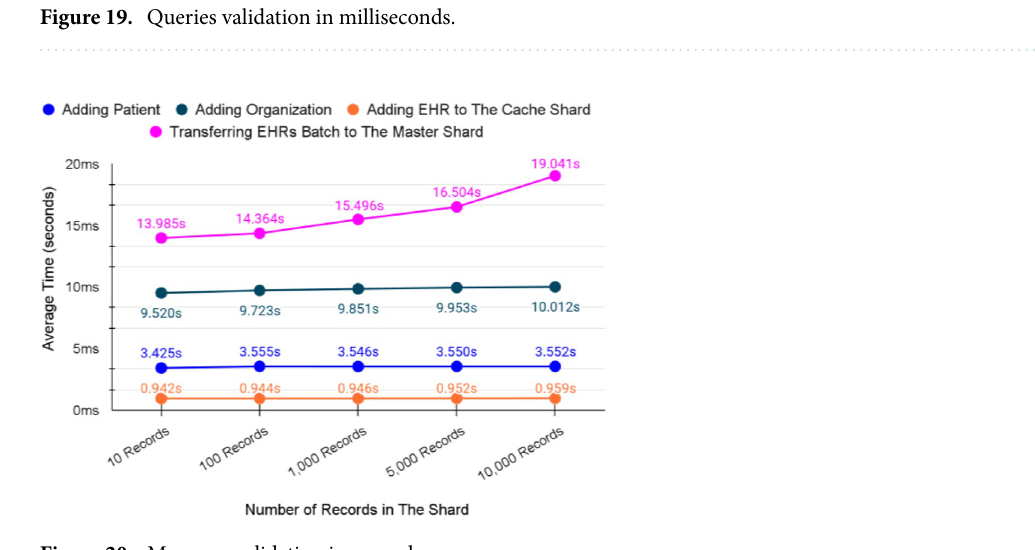
Figure 20. Messages validation in